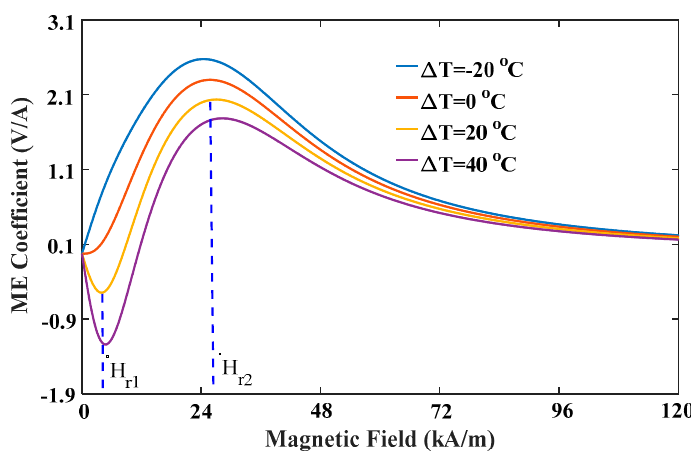
Figure 9. The ME coefficient varied with the applied magnetic field for different total thicknesses. From the perspective of application, when ME devices using multiferroic nanocomposites operates in space stations or satellites where the temperature difference is large between day and night, the thermal stability of the ME effect is a critical issue for the performance and sensitivity of sensors. In the following discussions, the flexoelectric coefficient and intrinsic length are fixed at -9 3 10 C m ×